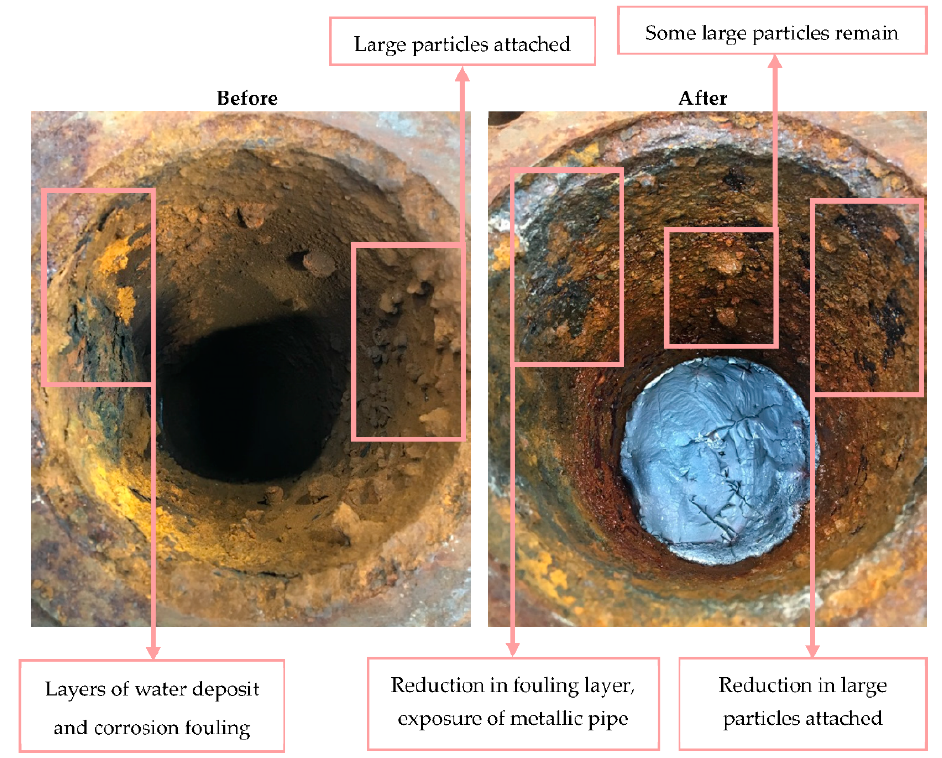
Figure 19. Before and after image of the inner wall of the U-shaped pipe. Table 6. Ultrasonic cleaning limiting parameters and further suggestions for optimization. Parameter Limitation Performance Optimization Optimize cleaning time to layer